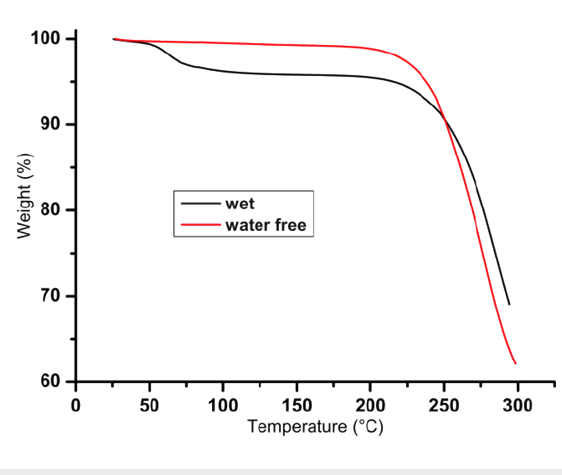
Figure 2: TGA measurements of wet and water free 1 12 imidazolium salt.